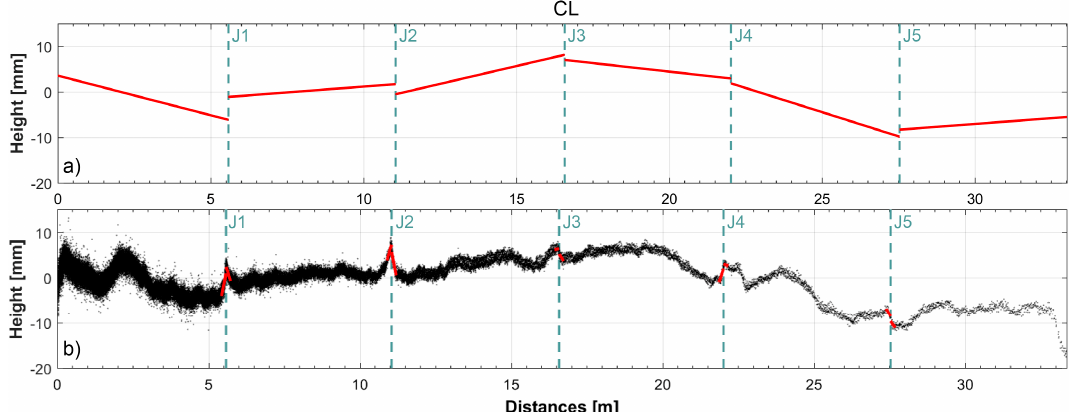
Figure 11. Profiles extracted along the center line. ( a ) profile extracted considering flat the slab surface. ( b ) point cloud (in black) and its linear interpolation for a 150 mm segment as of the joint (in red). Table 6. Faulting values, associated SD and ratio between faulting and SD computed taking into account the point cloud belonging to a 150 × 100 mm area. w i values exceeding 1.65 are highlighted in grey. J1 J2 J3